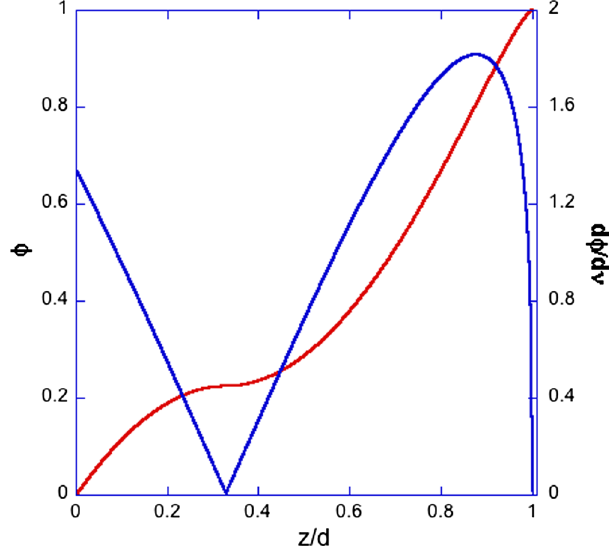
FIG. 8. Dimensionless potential (red, left scale) and its deriva- tive (blue, right scale) for α LE regime of Sec. II B. For LE the ffiffiffiffiffiffiffiffiffiffiffiffiffi p max 1 − φ , where φ 0 the value of Δ I is determined by the function plot in Fig. 7, for EX 0 Δ I ¼ 52 . 8 kA, for α ¼ α ¼ 3 . 7408 . See the text for the max meaning of the